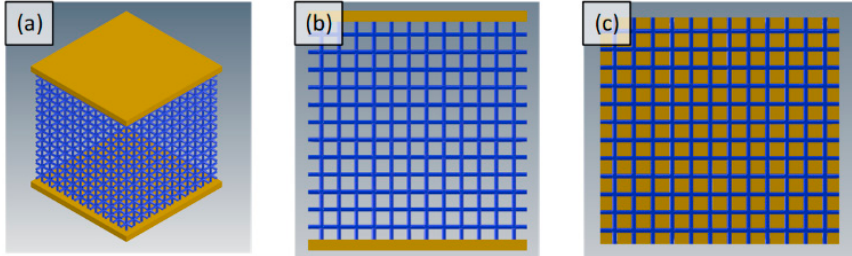
Figure 3. ( a ) Cube sample with plates on top and bottom; ( b ) cube sample from front view; and ( c ) top